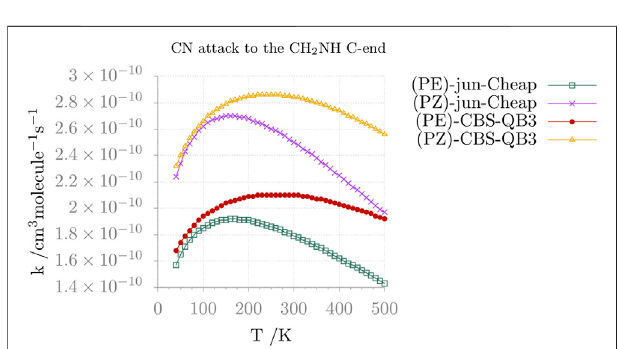
FIGURE 7 | Reaction rate constants (and their temperature dependence) for the formation of Z and E C-CMIM upon CN attack at the C-side of